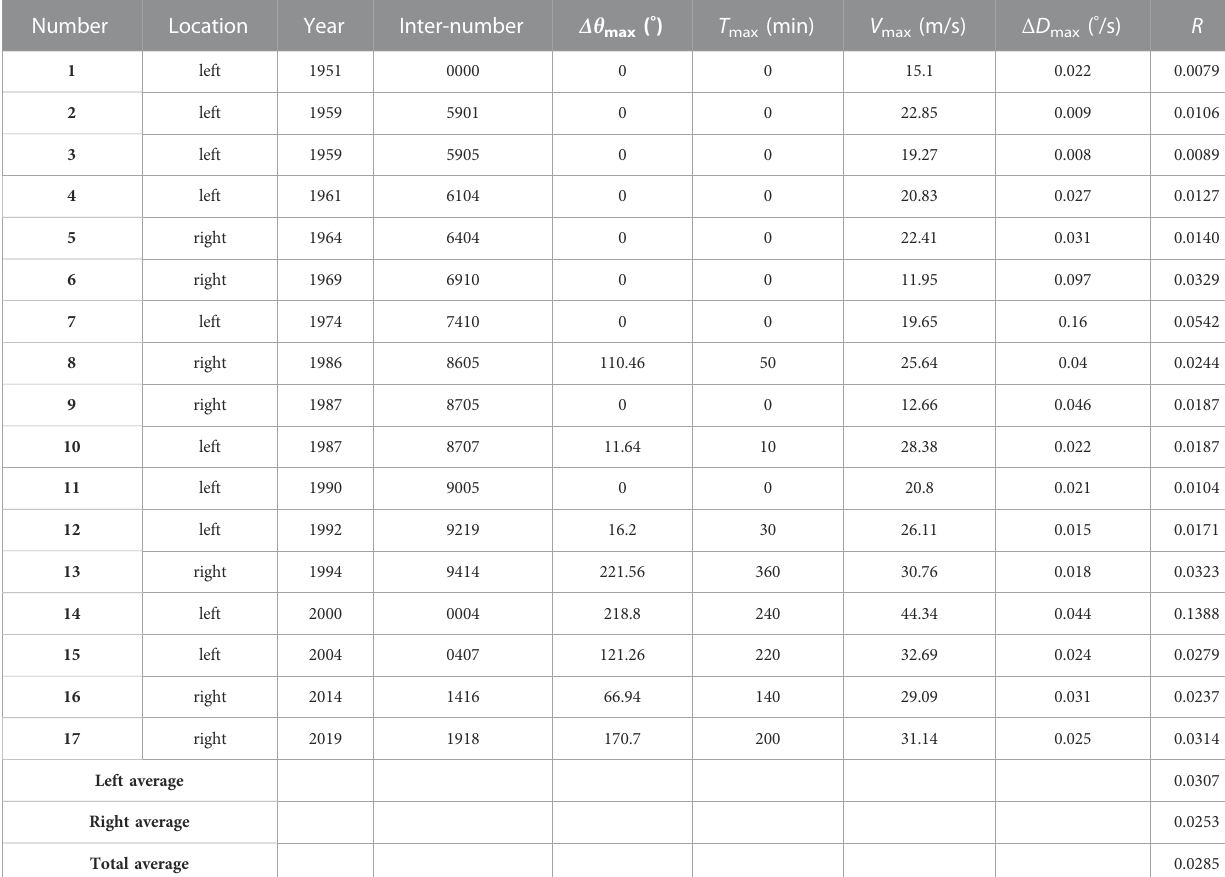
TABLE 7 Composite risk index (from south to